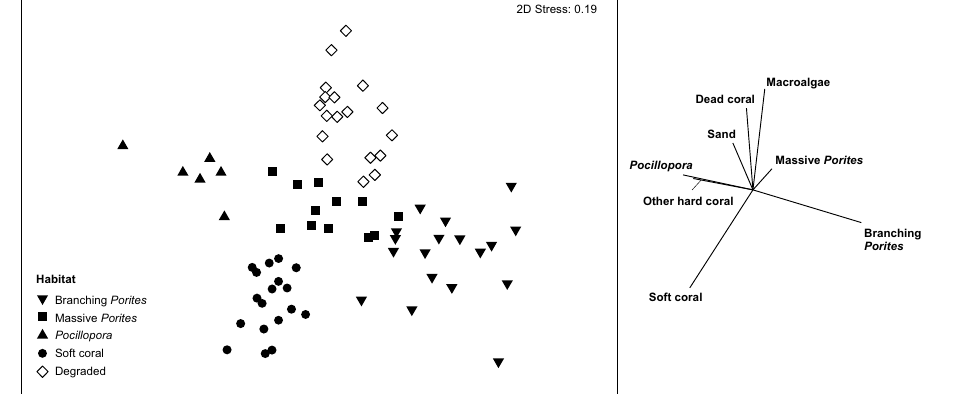
Figure 2. Non-metric multidimensional scaling analysis showing variation in benthic composition among surveyed reef habitats at Lizard Island, using transect level square root transformed data. The relative contribution of benthic categories to the observed variation in benthic composition are illustrated ( > 0.2 Pearson